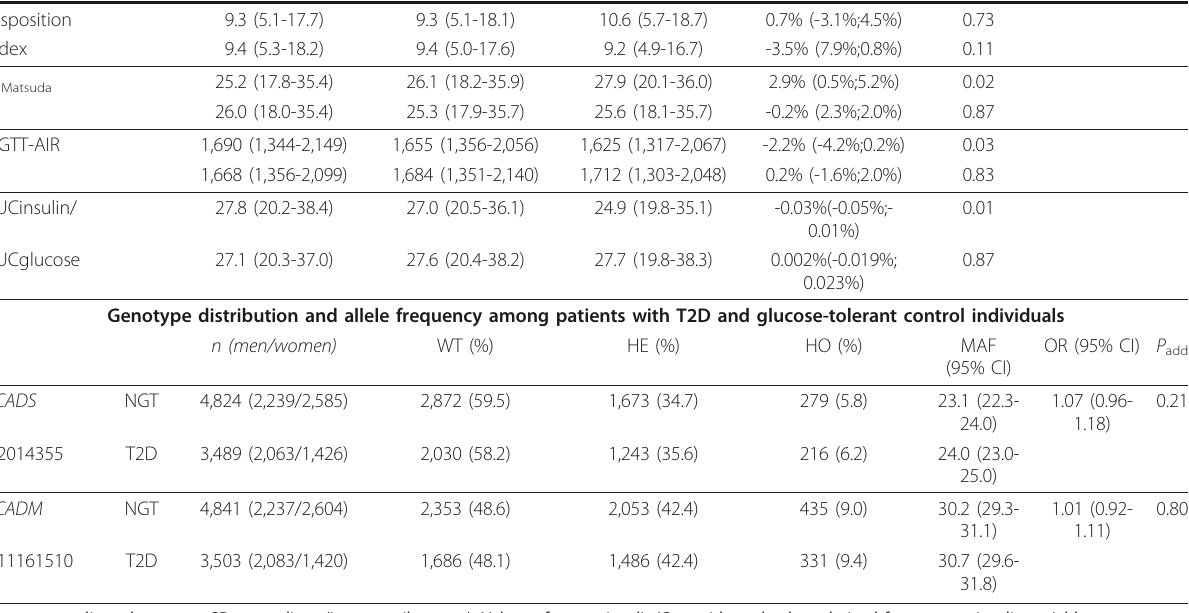
Data are unadjusted means ± SD or medians (interquartile range). Values of serum insulin/C-peptide and values derived from serum insulin variables were logarithmically transformed before statistical analysis, and their effect sizes are presented as the increase/decrease in percent. All analyses were made using an additive genetic model, adjusting for age, sex, and BMI. The bottom part of the table include number of individuals divided into genotype groups (% in each group), and frequencies of the minor allele (MAF) in percentages. Logistic regression was used to compare allele frequencies ( P add ) . The odds ratios (OR) and the 95% confidence interval (CI) are given for comparison of allele frequency. NGT: Glucose-tolerant individuals, T2D: type 2 diabetic patients. ACADS rs2014355 genotypes: WT, homozygous major T-allele carriers; HE, heterozygous; HO, homozygous minor C-allele carriers. ACADM rs11161510 genotypes: WT, homozygous major C-allele carriers; HE, heterozygous; HO, homozygous minor T-allele